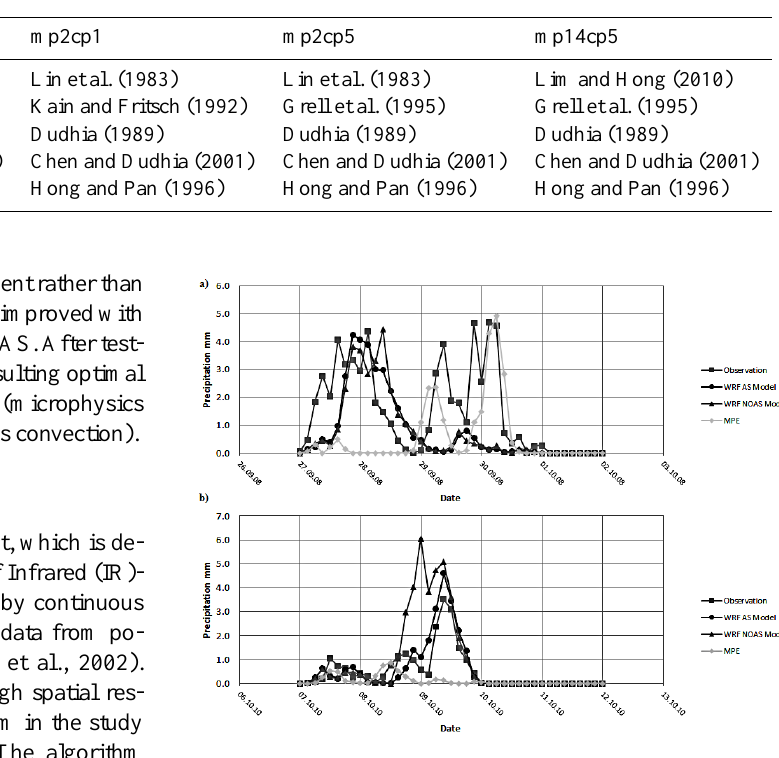
Fig. 4. Area-averaged time series of WRF AS, WRF NOAS, and MPE against observations are shown in (a) for event number 13 and (b) for event number